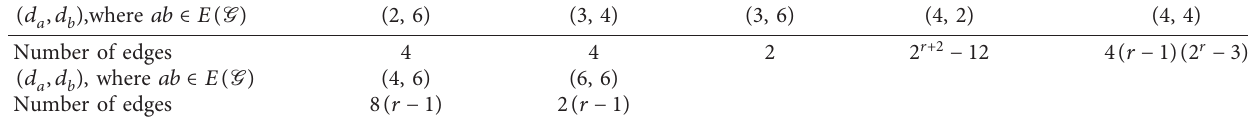
Table 2: The partition of edge set of HCB ( r ) built on the degree of end vertices of each edge. ,d ) ,where ab ∈ E ( G ( d a b